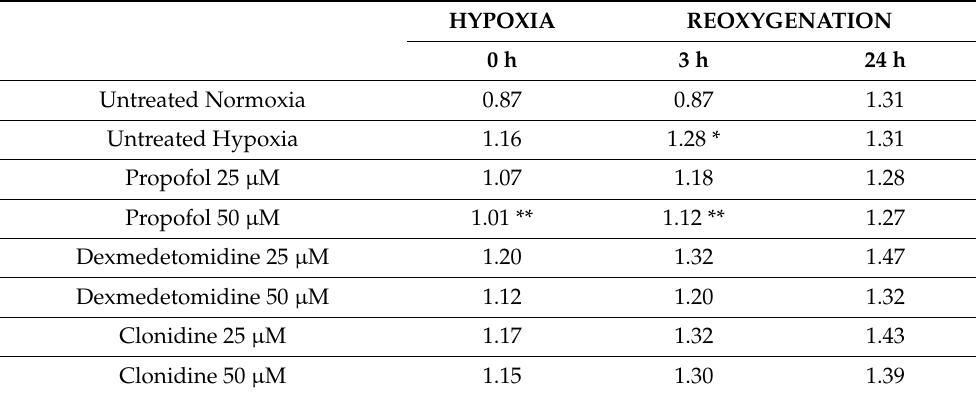
Table 2. Normalized cell Index raw data values. Normalized Cell Index raw data values during Hy- poxia and different time of reoxygenation following various pharmacological treatments. * p < 0.0001 vs. Untreated Normoxia, ** p < 0.005 vs. Untreated